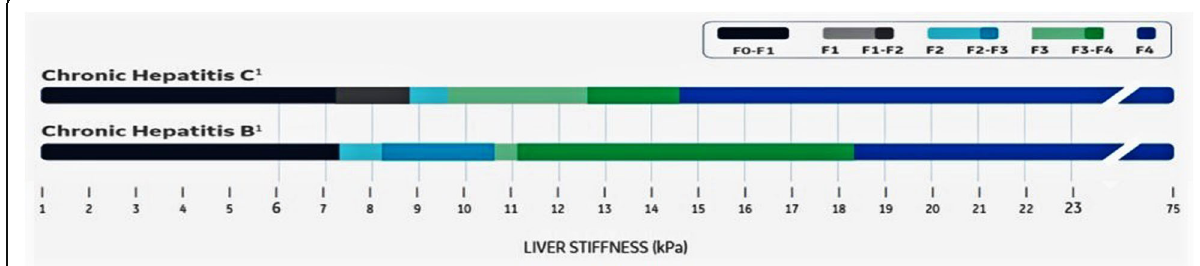
Fig. 1 The interpretation of TE or fibroscan results by kilopascal and the liver fibrosis staging (quoted from GE healthcare documents, 2017)